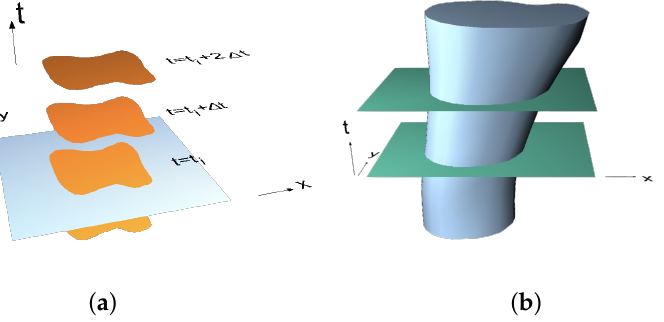
Figure 3. Exemplary 2D object in a classical approach ( a ) and evolving in space–time ( b